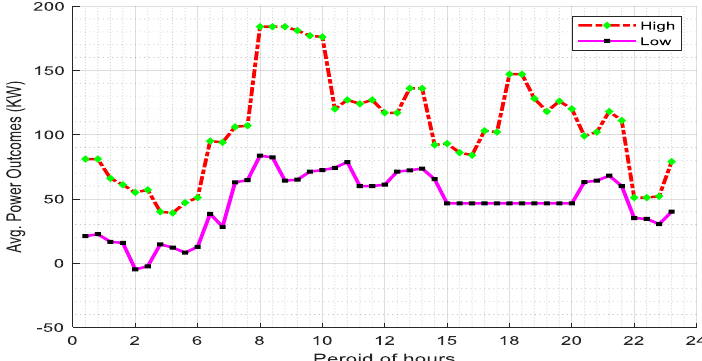
Figure 6. Daily demanding grid voltage curves of the microgrid power loads.